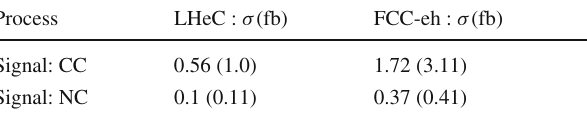
Table 1 SM cross sections for the CC and NC processes as shown in Fig. 1 for unpolarised ( − 80% polarised) 150 GeV electron beam colliding with 7 TeV and 50 TeV proton beams corresponding to LHeC and FCC-eh respectively